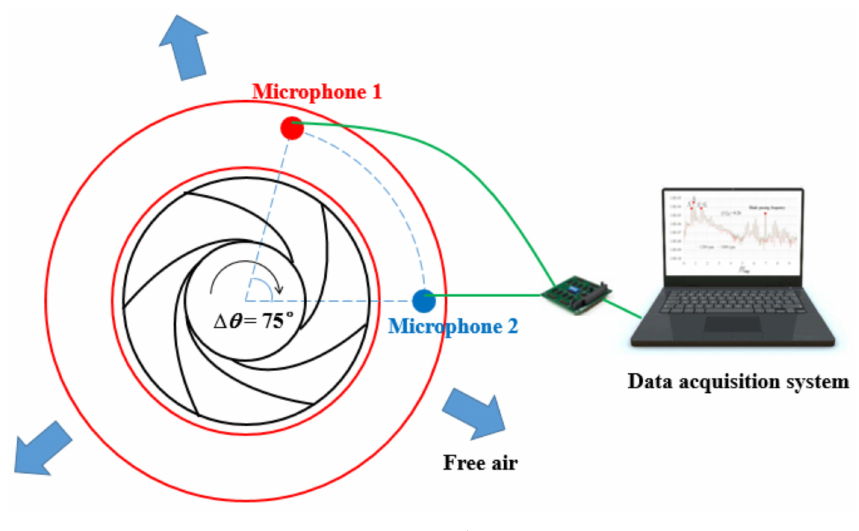
Figure 7. Experimental testing system. Table 3. Geometrical parameters of the centrifugal impeller and vaneless di ff user.